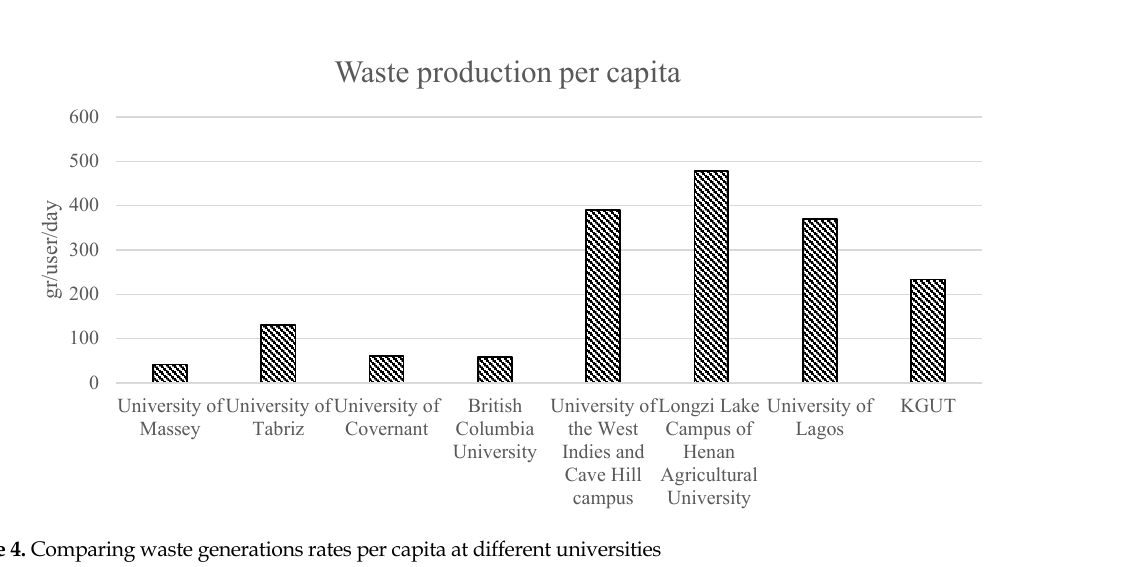
Figure 4. Comparing waste generations rates per capita at different universities